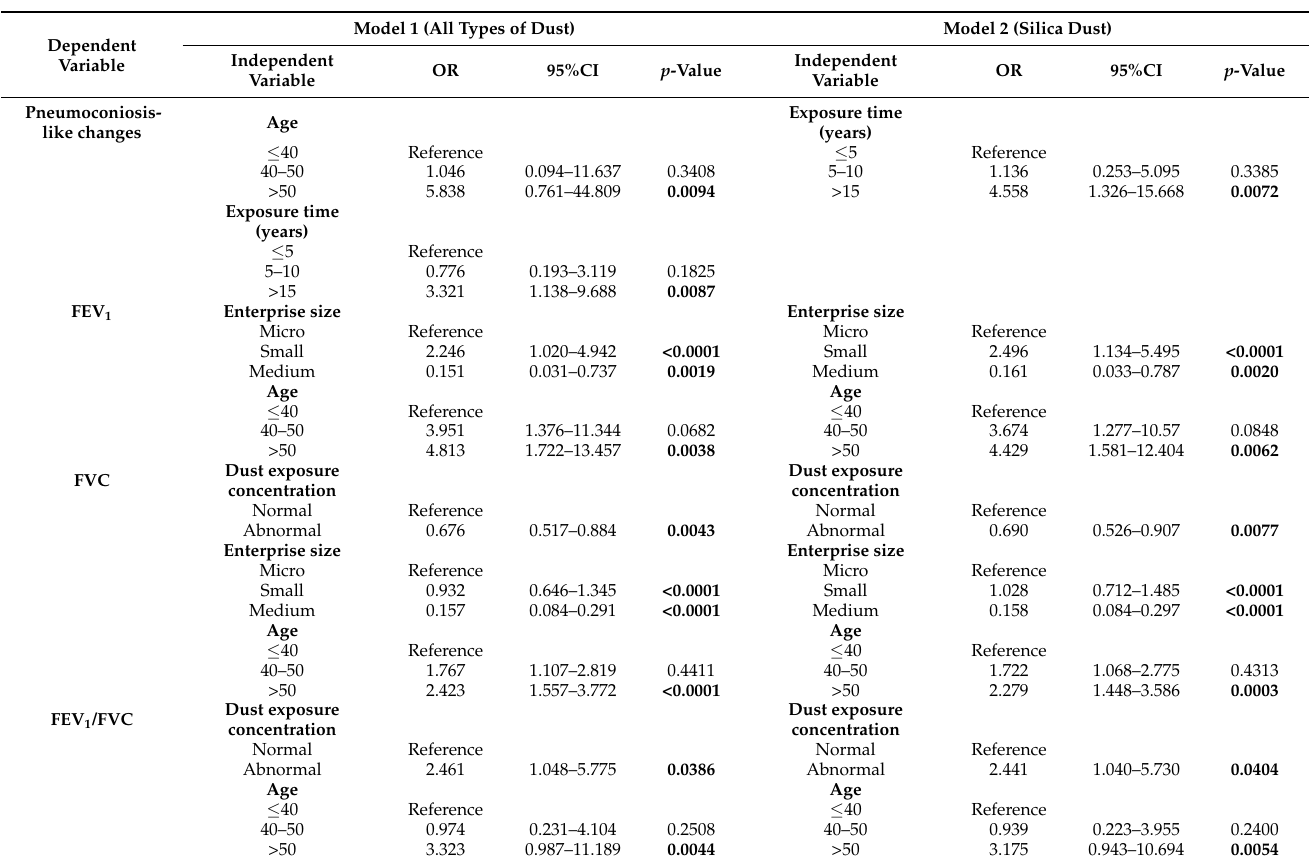
Table 3. Multivariate logistic regression analysis of pneumoconiosis-like changes and abnormal lung